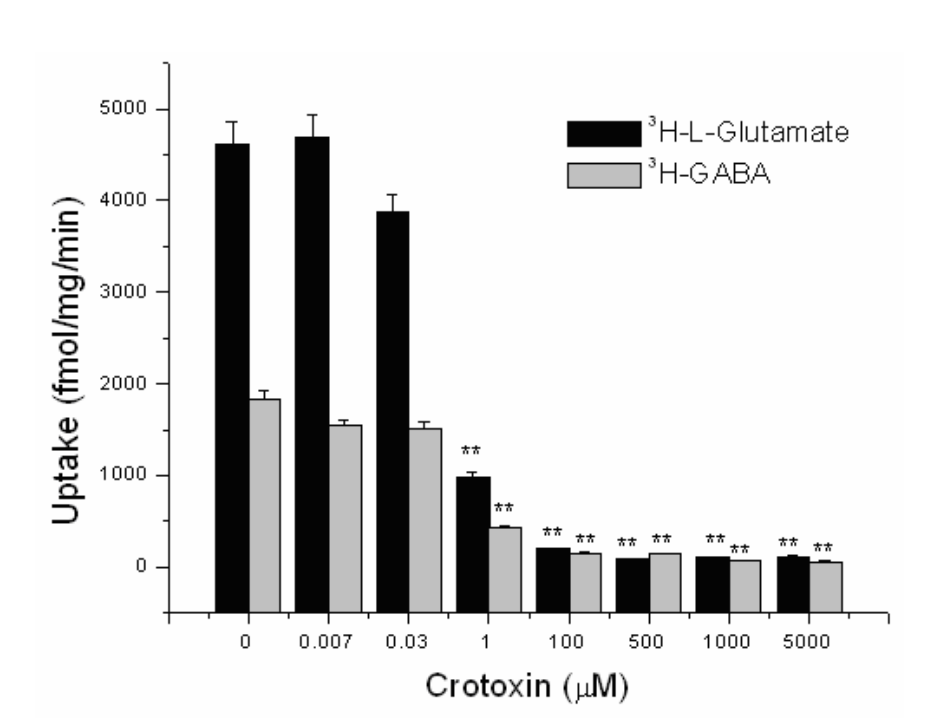
Figure 2. Inhibition of 3 H-L-glutamate and 3 H-GABA uptake by different crotoxin concentrations in